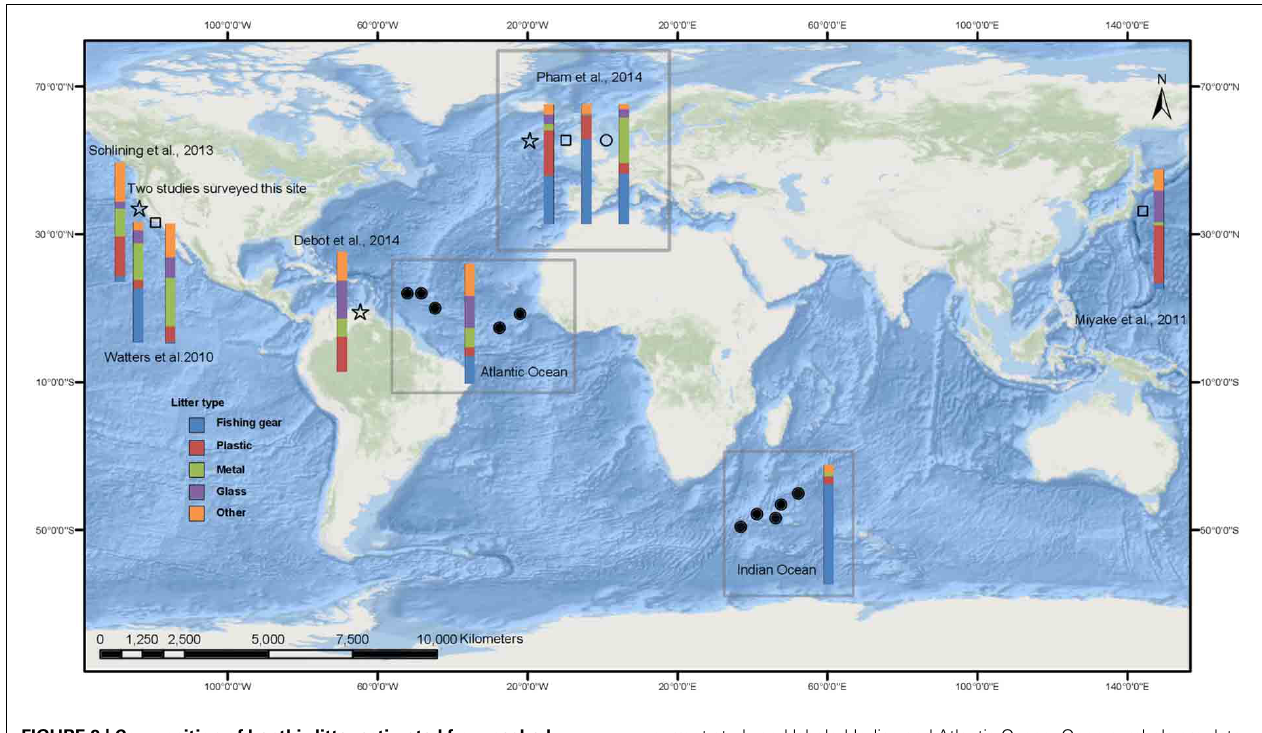
FIGURE 3 | Composition of benthic litter estimated from seabed observations. Circles represent studies on raised features such as seamounts, stars represent canyon studies and other topography is represented by a square. Filled symbols are the summary data from the